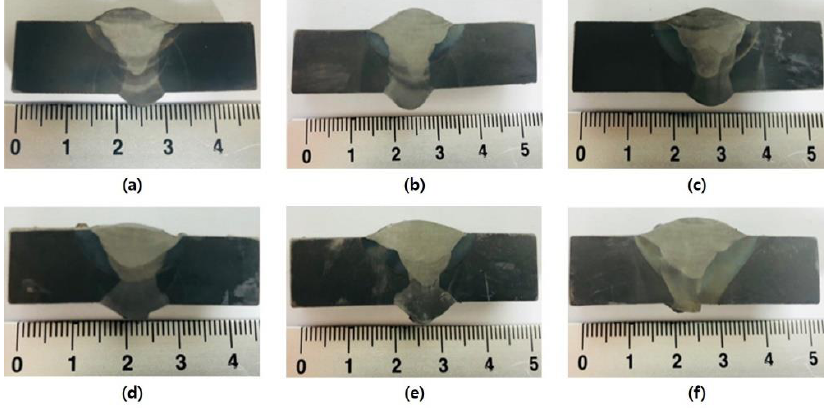
Figure 6. Cross-sectional view analysis of GMAW with CO 2 5% and 20% shielding gas and heat input in butt joint ( a ) 05L; ( b ) 05M; ( c ) 05H; ( d ) 20L; ( e ) 20M; ( f ) 20H.